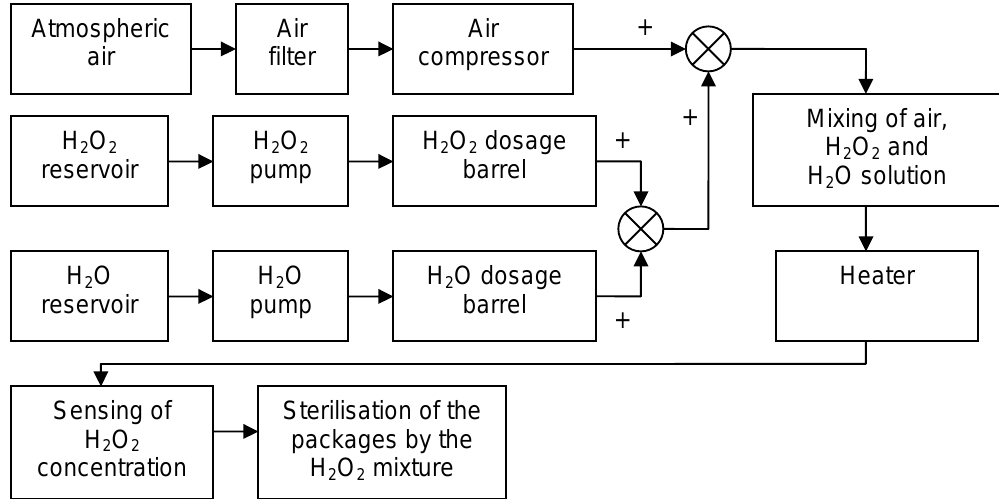
Figure 1. Block diagram and principle of the sterilisation